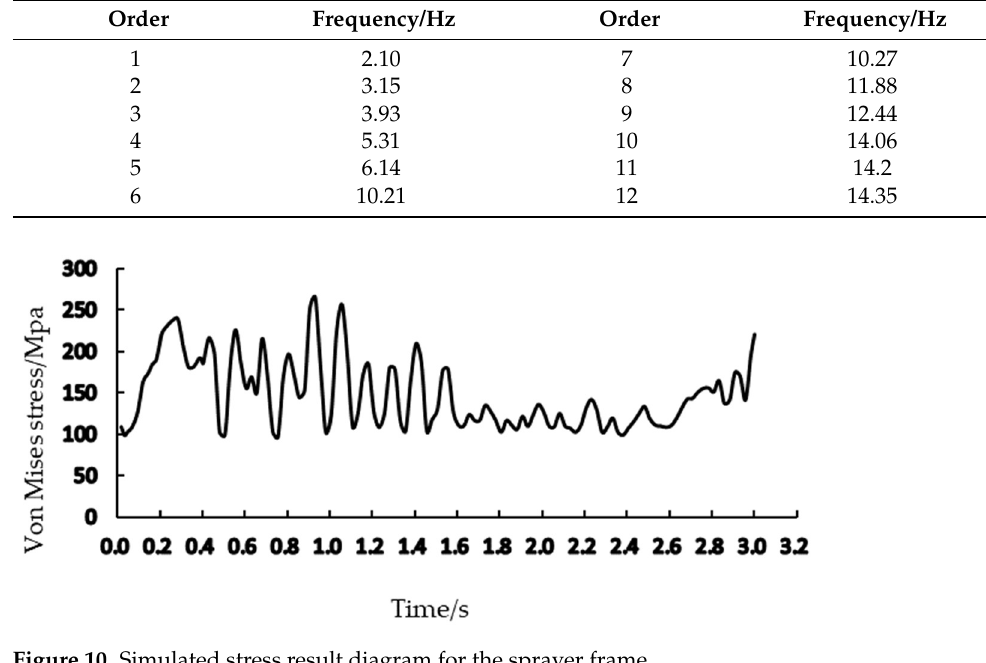
Figure 10. Simulated stress result diagram for the sprayer frame.